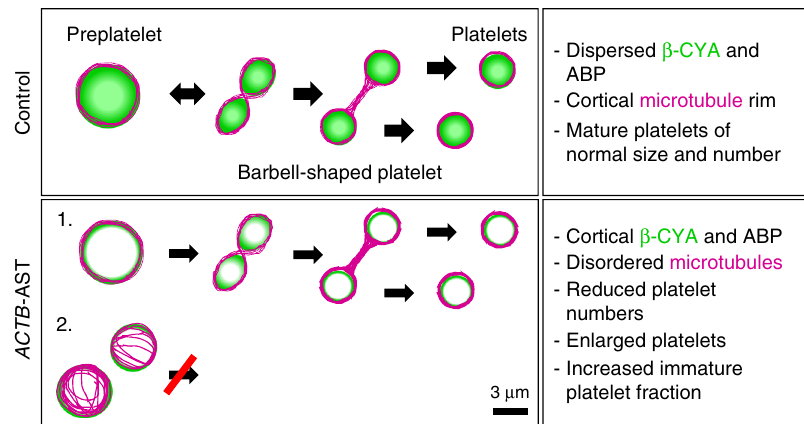
Fig. 9 Proposed model of the mechanisms underlying thrombocytopenia in ACTB -AST. Preplatelets and barbell-shaped platelets shed into the blood stream convert into platelets in a microtubule-dependent manner. A thick band of microtubules is responsible for twisting the center of the preplatelet to form the barbell-shaped platelet, essentially dividing it into two individual terminal platelets. Abscission of terminal platelets subsequently occurs in the circulation. In ACTB -AST patients, cytoplasmic actin isoforms and select ABPs ( α -actinin 1, NM-2A and to a lesser extent Filamin A) enrich at the preplatelet cortex. The cortical microtubule band observed in mature control cells forms in fewer ACTB -AST platelets. Instead, microtubules are highly disordered. We propose that the fi nal platelet processing steps are therefore restricted in preplatelets with a disordered microtubule cytoskeleton, leading to reduced numbers of enlarged and immature platelets in patient